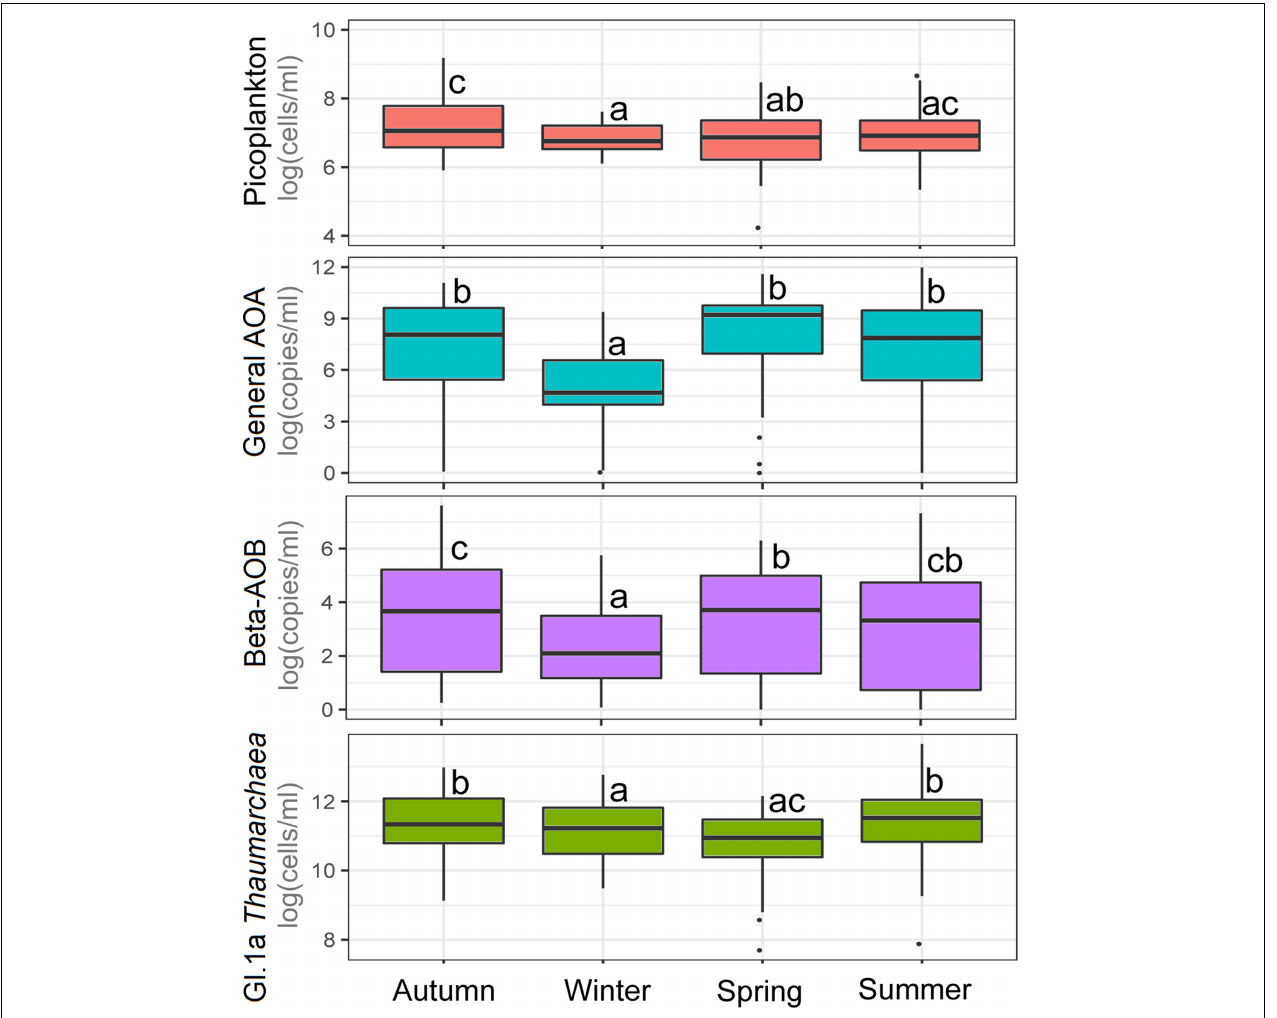
FIGURE 3 | Seasonal variation in abundance of major structural components of prokaryote community in the study area. Box plots show the medians, upper/lower quartiles (boxes) and value range (vertical lines) of data sets. Different letters denote significant differences at a P -value of <